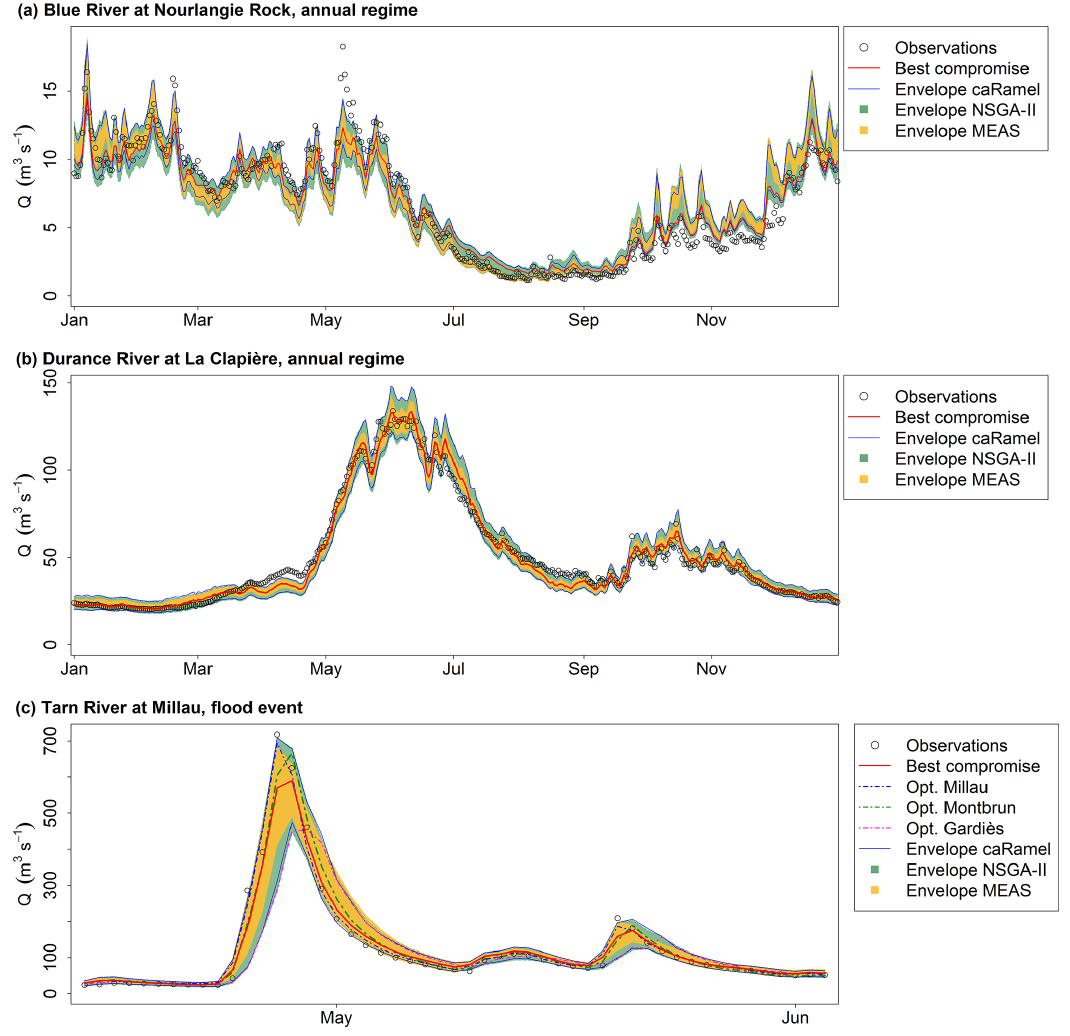
Figure 11. Observed and simulated discharges for the three case studies. “Observations” refer to the observed discharges, “Best compromise” refers to the best compromise simulated discharges and “Envelope” refers to the simulated discharges envelope using all parameter sets on the Pareto front (over 40 optimizations) with caRamel, NSGA-II and MEAS. (a) Daily runoff regime of Blue River at Nourlangie Rock (1990– 1999); (b) daily runoff regime of Durance at La Clapière (1991–2000); (c) flood event for the Tarn River at Millau (14 April 1993–3 June